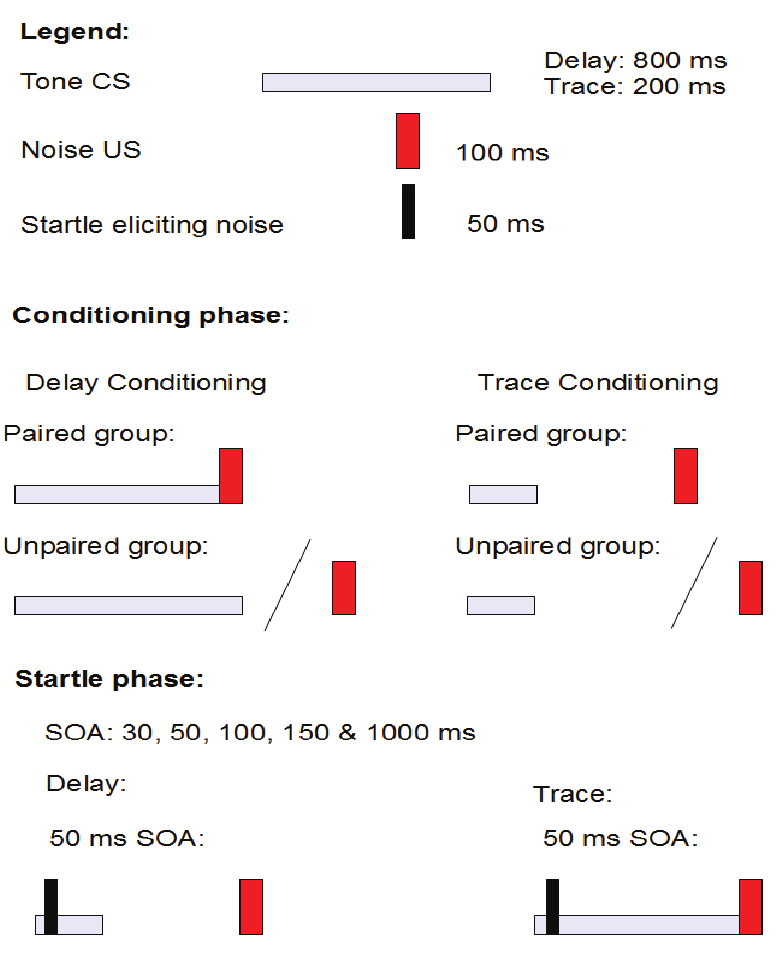
Figure 3. A schematic presentation of the structure of the experiment in Åsli et al.